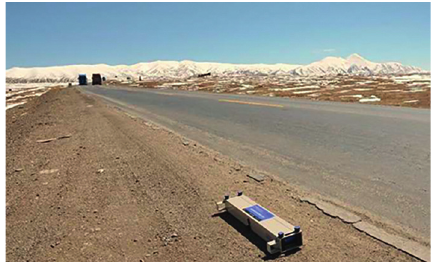
Figure 3: Image of the applied vehicle classification